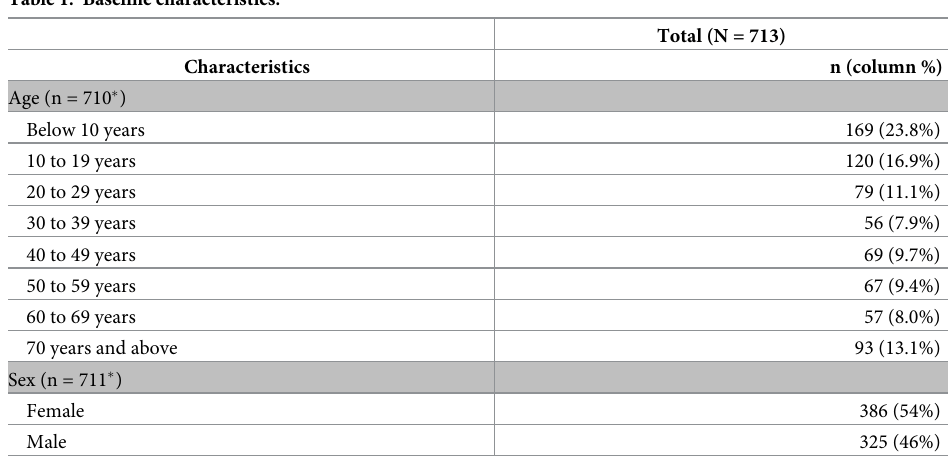
Table 1. Baseline characteristics.